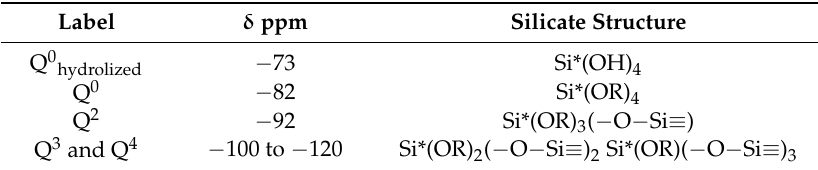
Table 3. 29 Si chemical shifts and corresponding silicate structures [30].